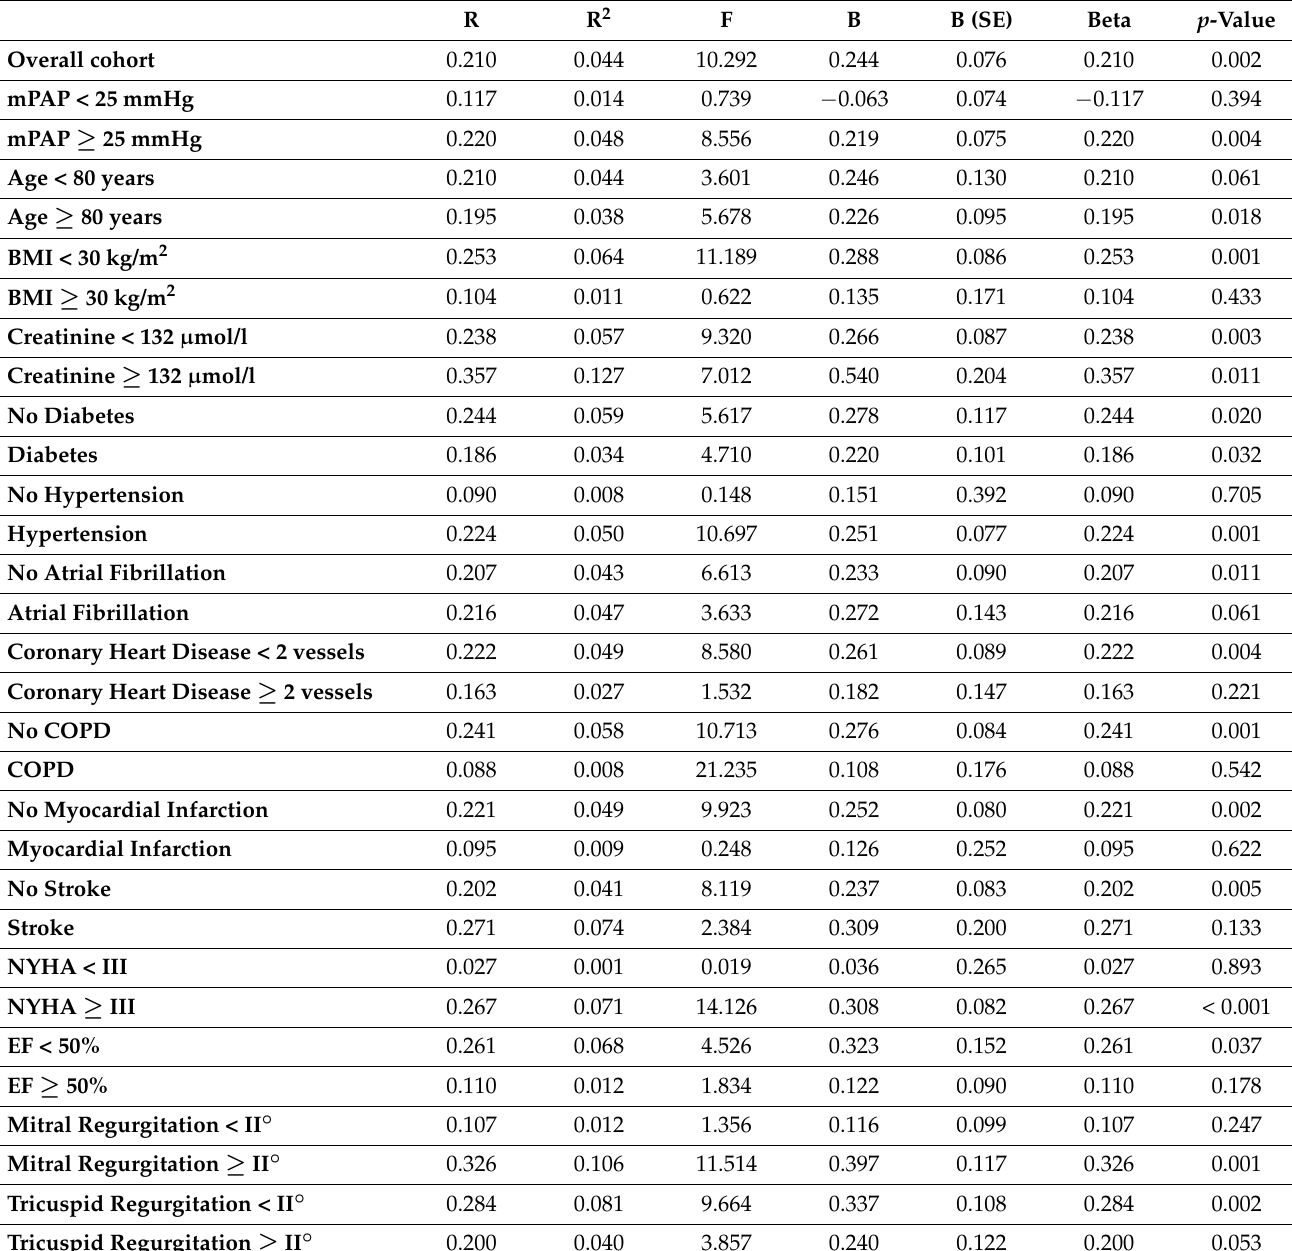
Table 2. Tabular overview of regression analysis with regard to various, clinical characteristics. mPAP: mean pulmonary arterial pressure; BMI: body mass index; EF: ejection